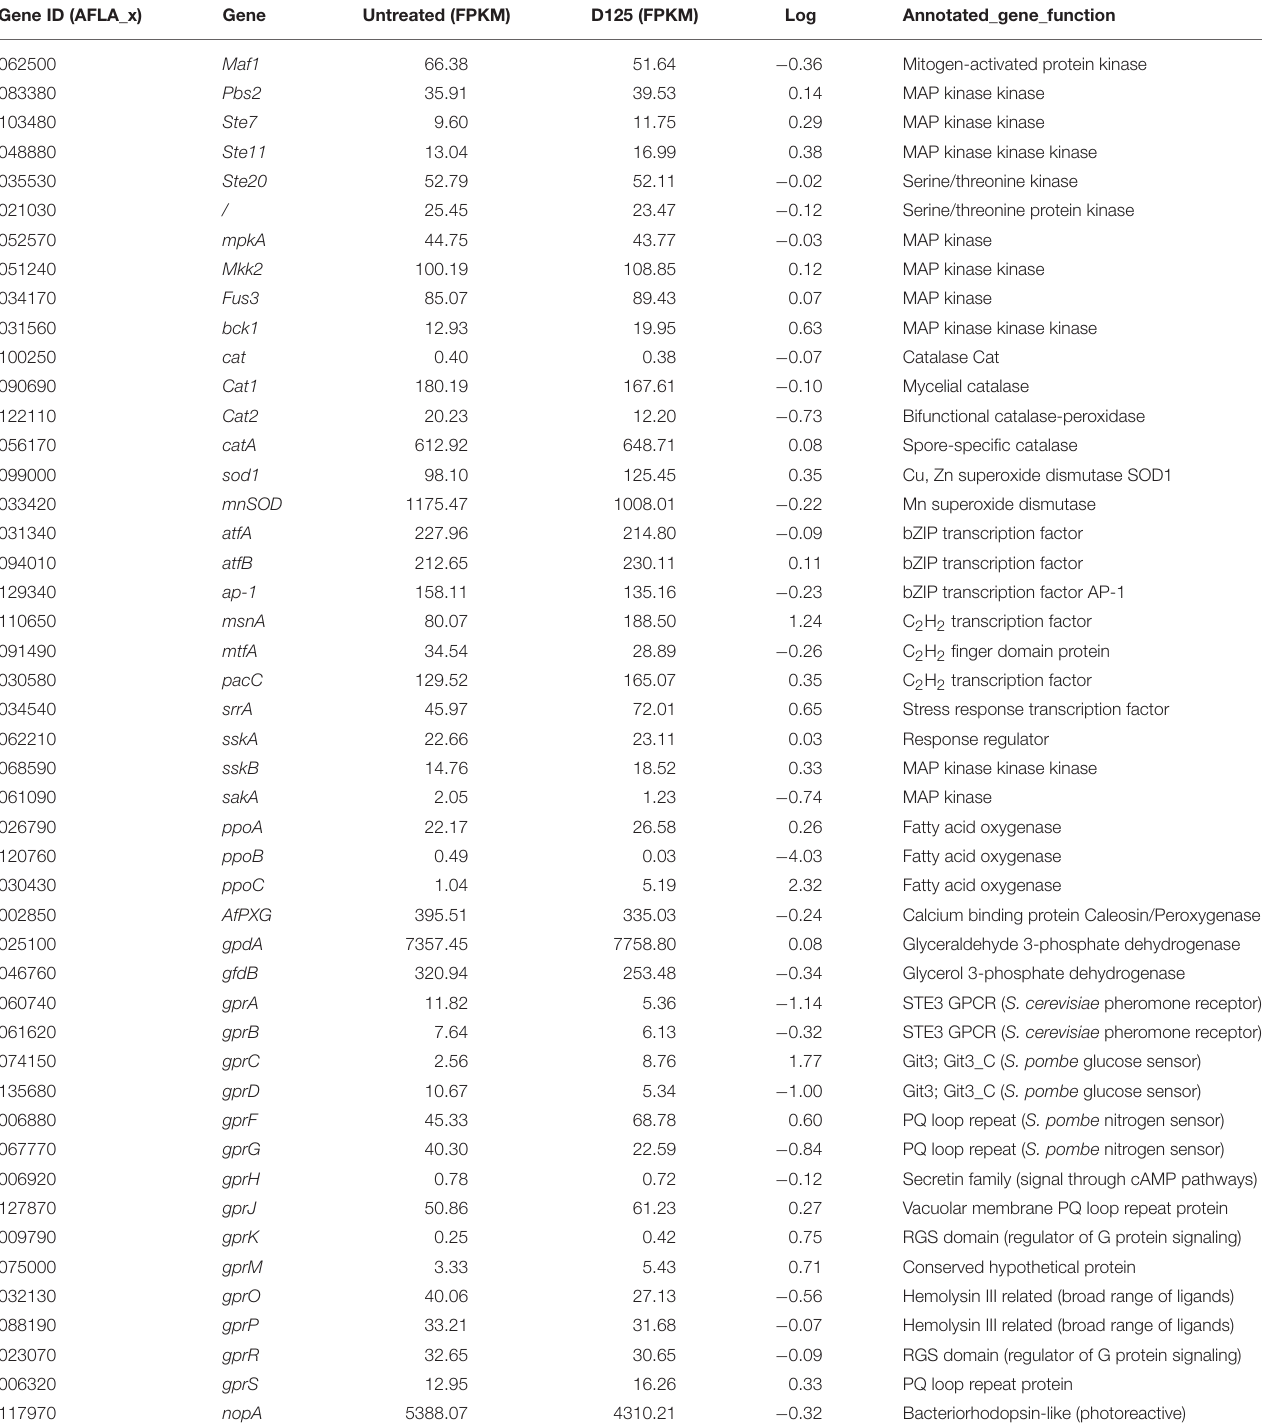
TABLE 5 | Transcriptional activity of MAPK pathway, Oxylipins, and GPCRs genes in A. flavus